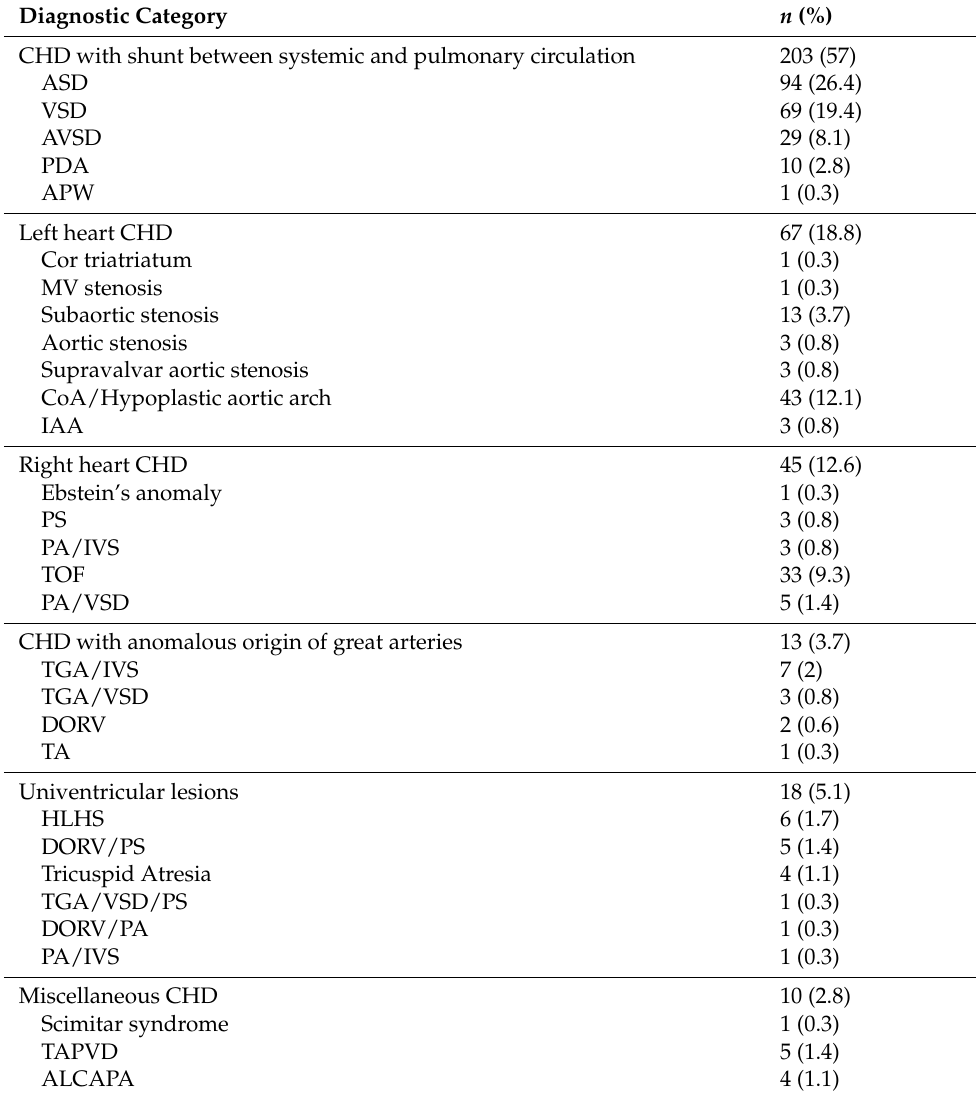
Table 2. Patients detailed cardiac anatomy ( n =